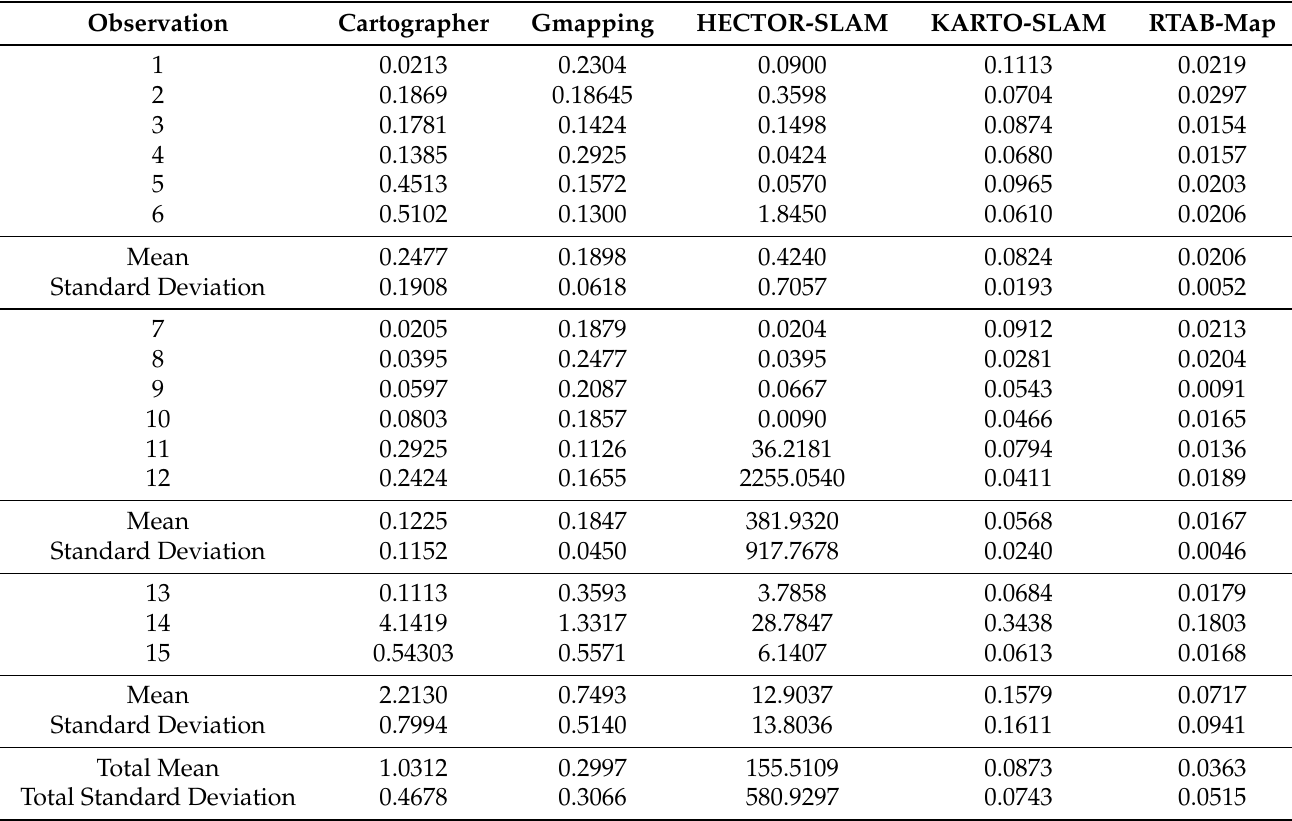
Table 11. Observation means for pose